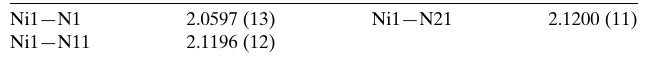
Table 1 Selected bond lengths (A˚ ) for 1 .